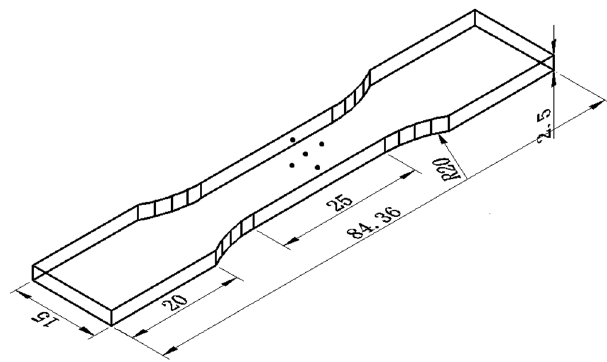
Figure 1. Size of tensile sample(mm).